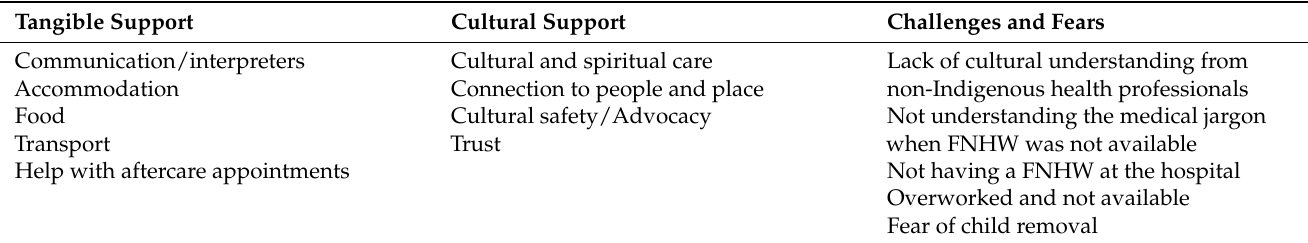
Table 1. First Nations children’s and families’